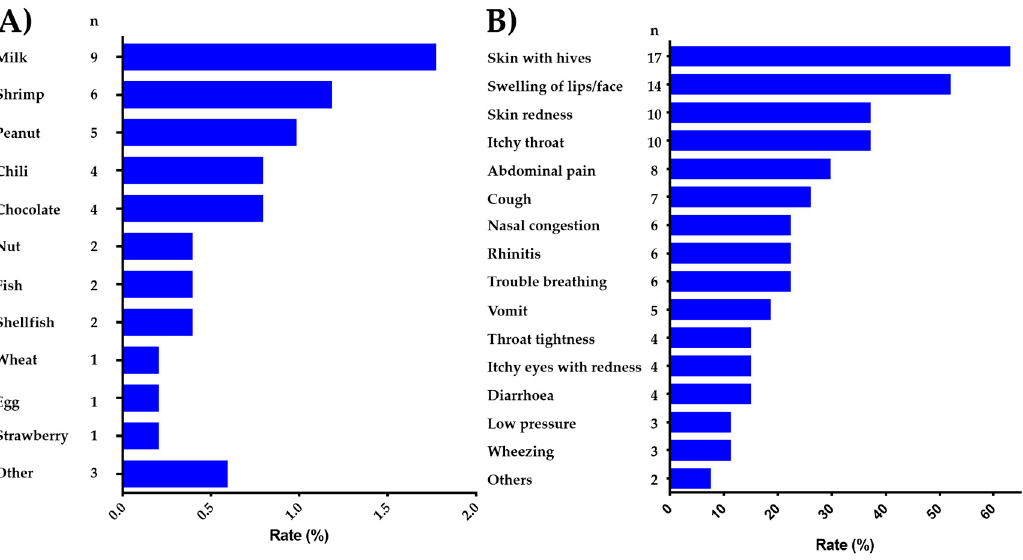
Figure 2. Specific food allergens and symptoms associated with “immediate-type FA, current”. ( A ) Prevalence of “immediate-type FA, current” by food in Salvadoran schoolchildren ( n = 508); ( B ) Prevalence of specific symptoms in Salvadoran schoolchildren with “immediate-type FA, current” ( n =